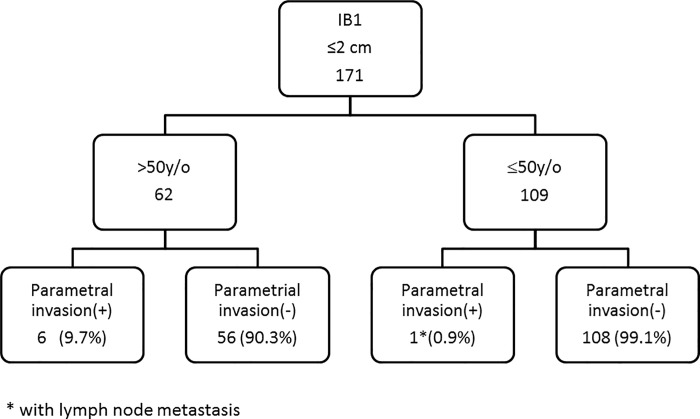
Scenario two to determine the need for parametrectomy during hysterectomy, according to patient age.